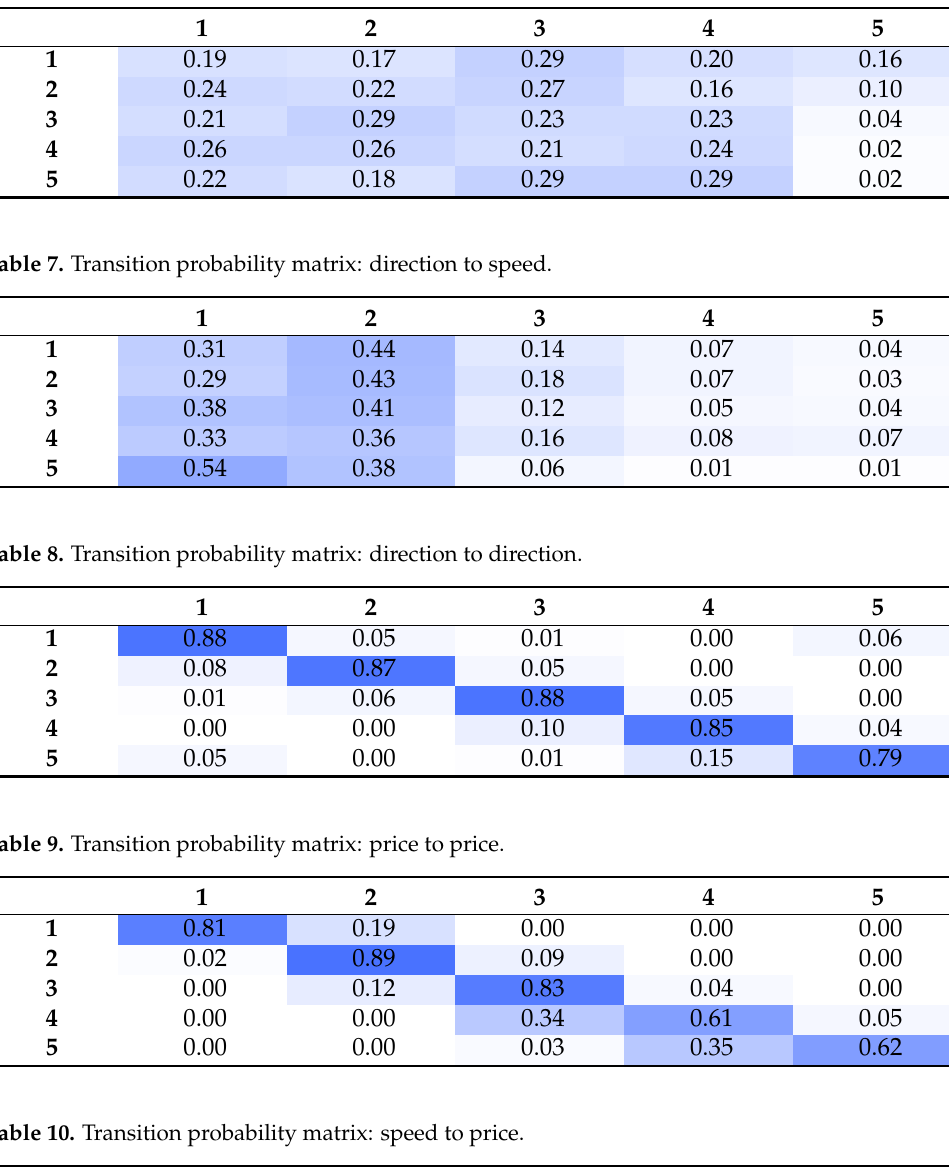
Table 6. Transition probability matrix: speed to direction.